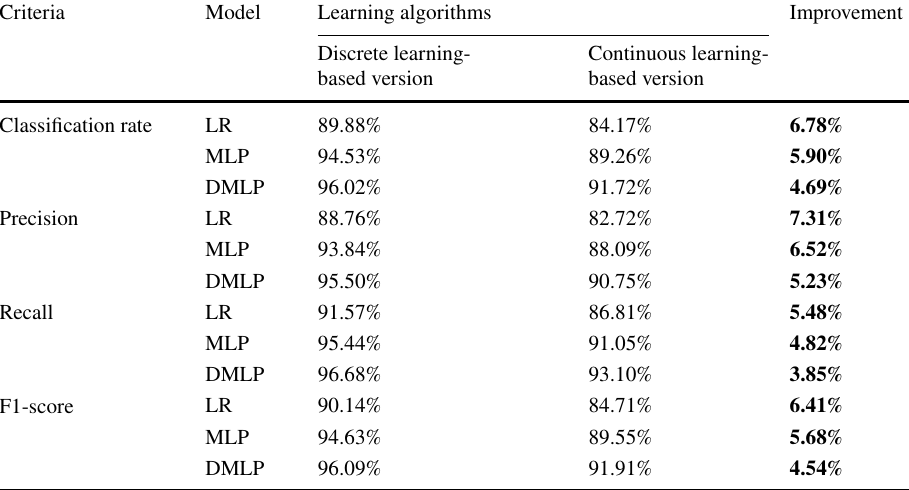
Bold values indicates the average and